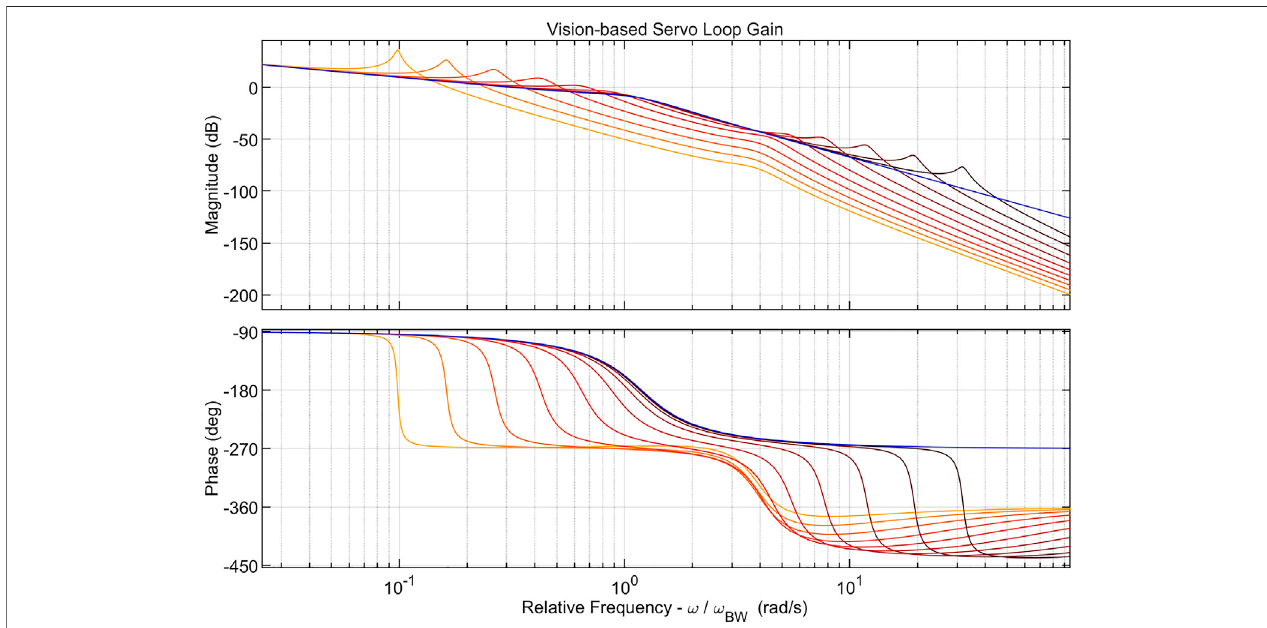
FIGURE10| Samplefrequencyresponseplotofnominal(blue)andperturbed(red)vision-basedservoloopgain.Multipleredcurvescorrespondtotheloopgainat ∈ { 0 . 1 , 10 } with darker color indicating higher frequency. Perturbation inertia fraction and damping are fi xed ( α (cid:2) 0.9, ξ (cid:2) 0.01). different perturbation frequencies ω o ω BW